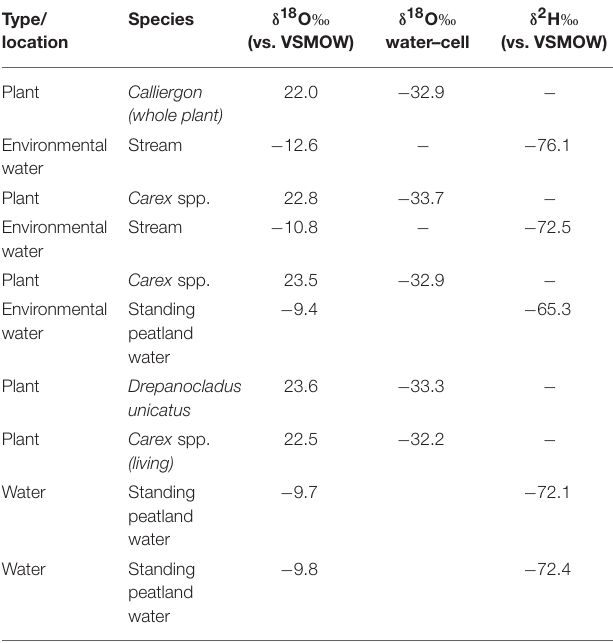
TABLE 4 | St Matthew Island plant cellulose and environmental water isotopes (sampled 6/2016).